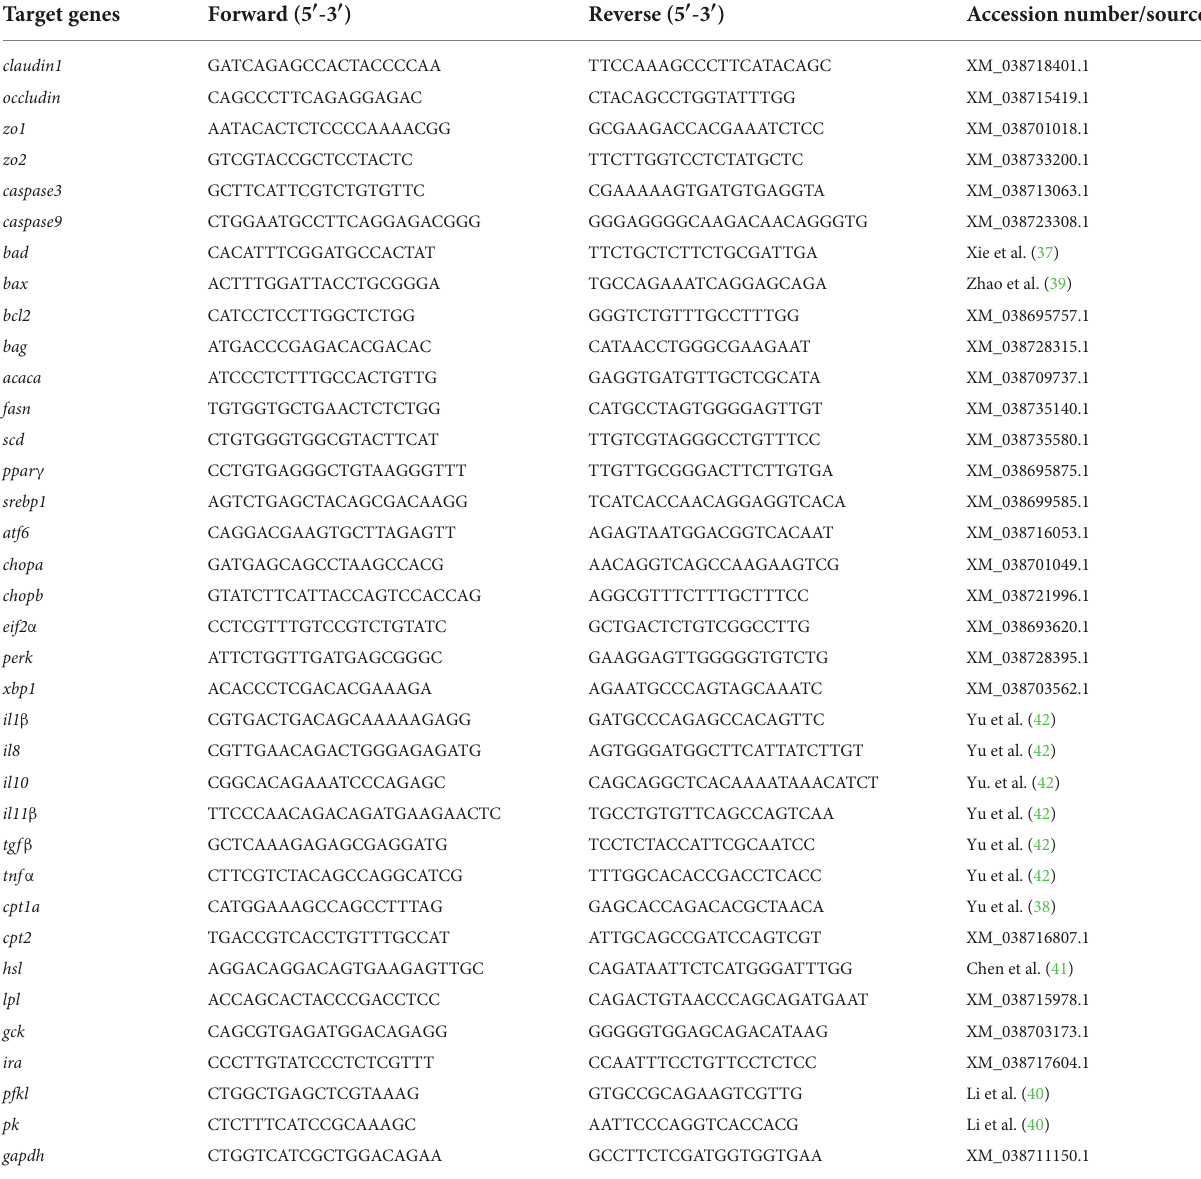
TABLE 2 Primers used for gene expressions assay by